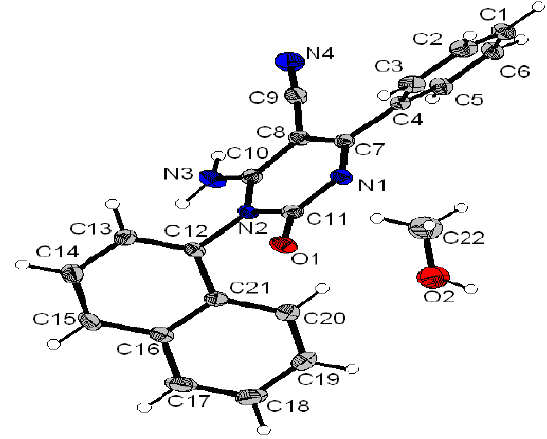
Figure 2. X-ray crystal analysis of compound 3b .